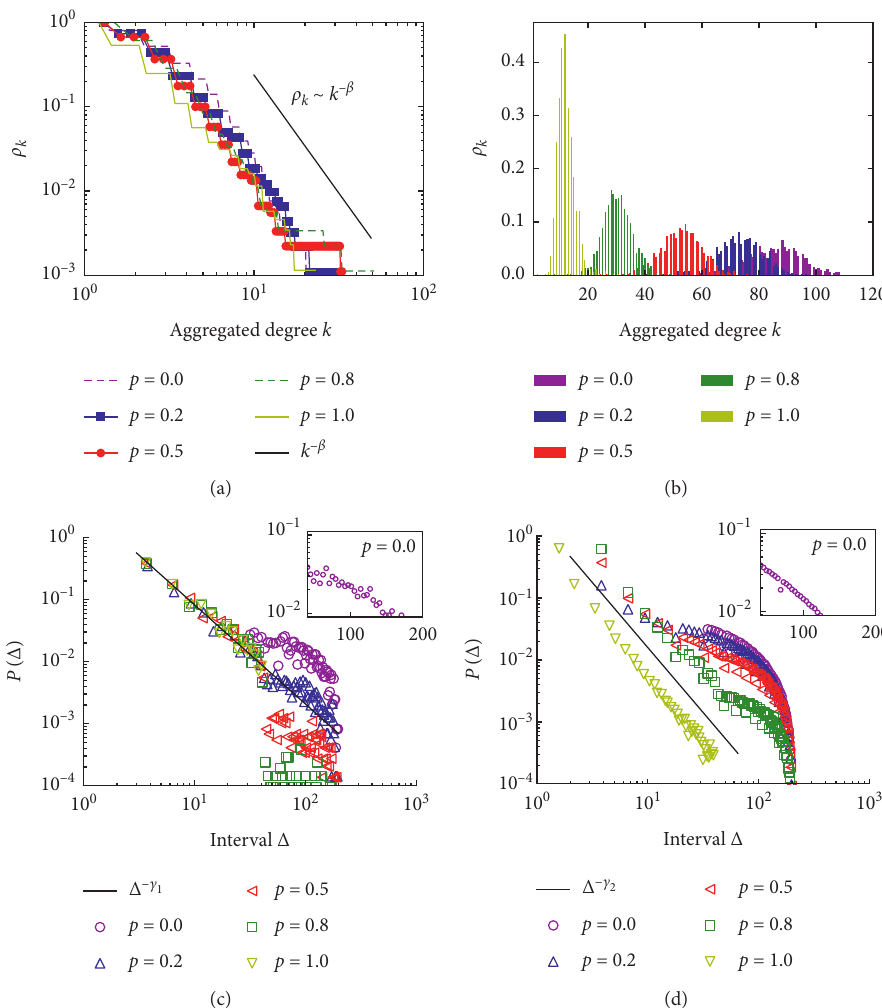
Figure 7: (a, b) The degree distributions ρ for one simulation. We fix N � 1000, A � 1, α � 1, P power-law distribution F ( s ) � ( s / s distribution Norm ( μ , σ 2 ) , with the mean μ � 5 and variance σ 2 � 1 and c when p � 0 (insets of (c) and